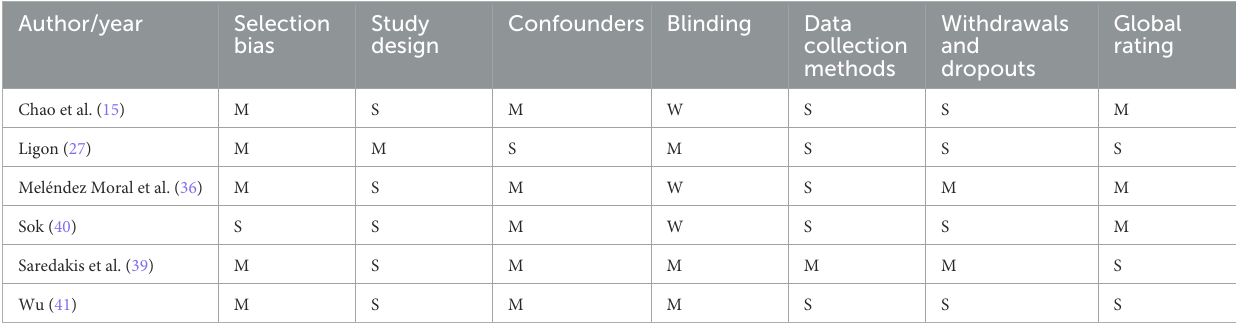
TABLE 1 Quality evaluation of quasi-experimental studies.